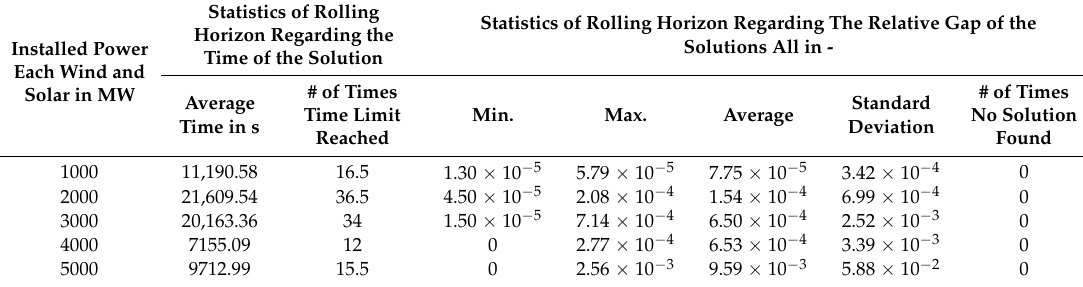
Table A9. Statistics for 30 days optimisation of MILP